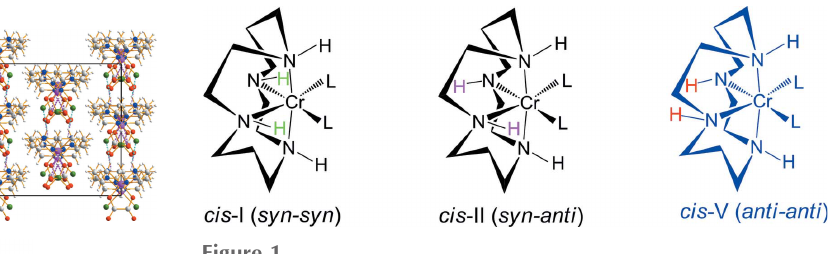
Figure 1 Possible conformers of cis -[Cr L 2 (cyclam)] n+